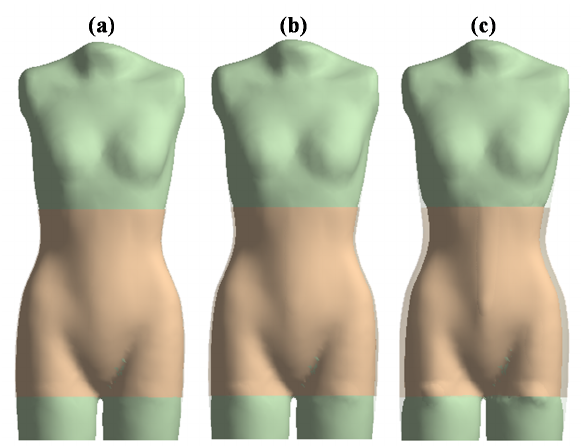
Figure 5. The human body deformed results while the abdomen circumference decrease was set as ( a ) 10 cm, ( b ) 15 cm, and ( c ) 30 cm.